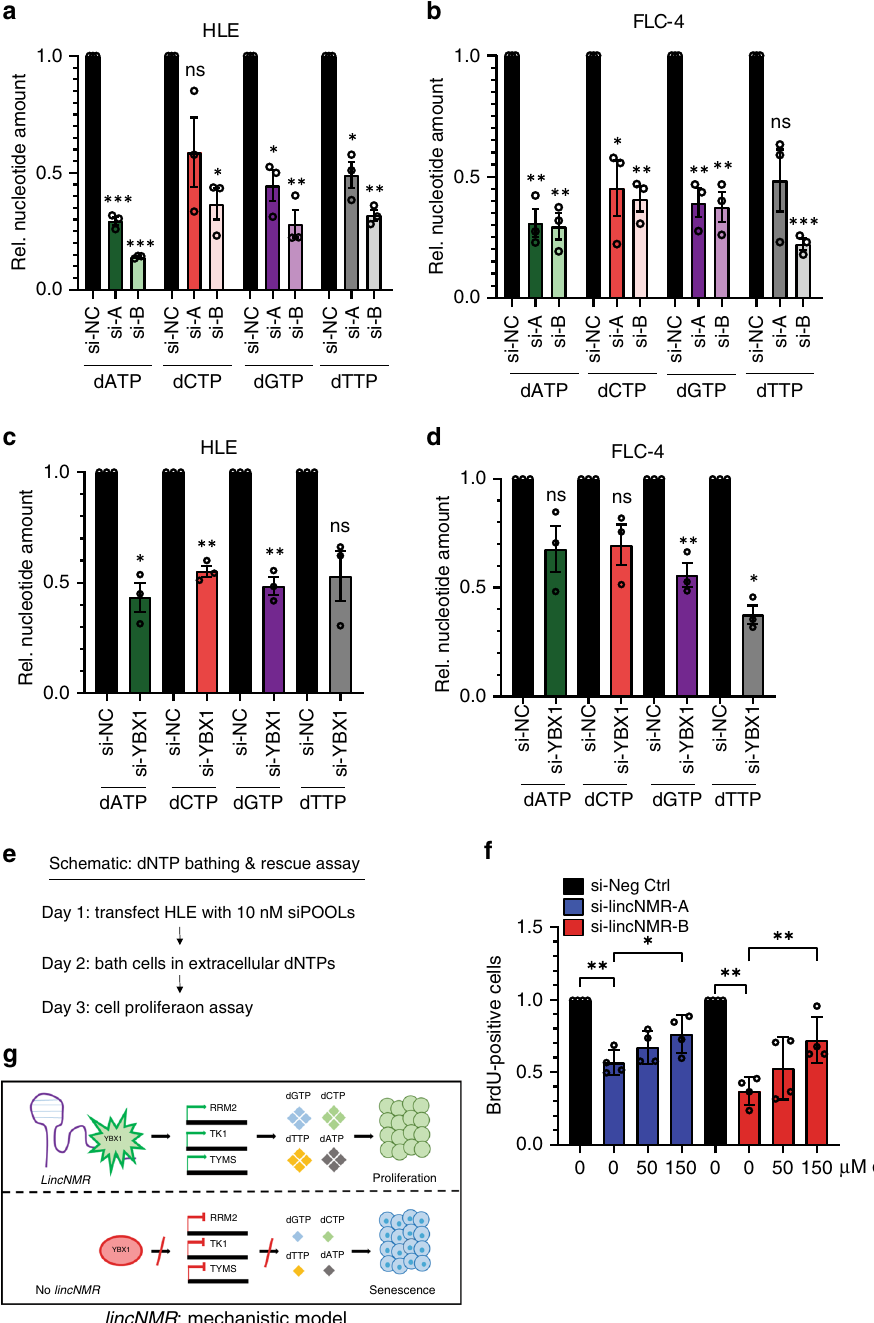
Fig. 7 LincNMR depletion reduces dNTP levels while supplying dNTPs rescues the lincNMR phenotype. a Quanti fi cation of dNTP levels uncovers that the depletion of lincNMR with 10 nM siPOOLs leads to strong downregulation of dATP, dCTP, dGTP, and dTTP in HLE cells ( n = 3). b Quanti fi cation of dNTP levels uncovers that the depletion of lincNMR with 10 nM siPOOLs leads to strong downregulation of dATP, dCTP, dGTP, and dTTP in FLC-4 cells ( n = 3). c Quanti fi cation of dNTP levels uncovers that the depletion of YBX1 with 10 nM siPOOLs leads to downregulation of dATP, dCTP, dGTP, and dTTP in FLC-4 cells ( n = 3). d Quanti fi cation of dNTP levels uncovers that the depletion of YBX1 with 10 nM siPOOLs leads to downregulation of dATP, dCTP, dGTP, and dTTP in FLC-4 cells ( n = 3). e Schematic outline of dNTP bathing & rescue assay. f Supplying dNTPs rescues dose-dependently the proliferation decrease caused by lincNMR silencing determined by a BrdU incorporation assay. HLE cells were reverse transfected with 10 nM of the respective siPOOLs and bathed in increasing concentrations (0 – 150 µ M) of extracellular pools of dNTPs 24 h post lincNMR depletion ( n = 4). Data shown represent the results of the cell proliferation assay normalized to negative control siPOOL with the respective dNTP concentration. g Proposed model of lincNMR molecular mechanism. a – d , f Data shown are normalized to negative control siPOOL. Data represent mean, and error bars represent SEM. Signi fi cance was calculated by unpaired, two-tailed t test with * P < 0.05; ** P < 0.01; *** P <